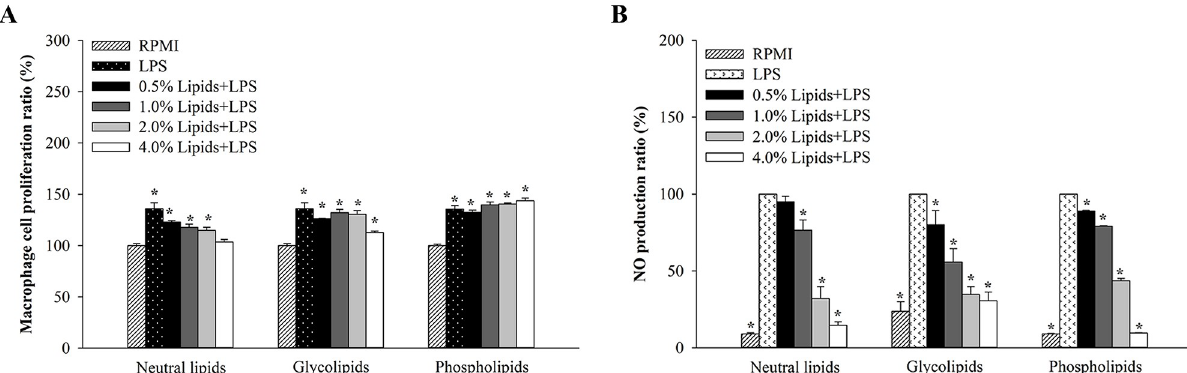
Fig 2. The effects of neutral lipids, glycolipids and phospholipids from H . aurantium tunic on macrophage proliferation. (A) Cell proliferation. (B) NO production. Significant different at p < 0.05 ( � ) compared with RPMI.